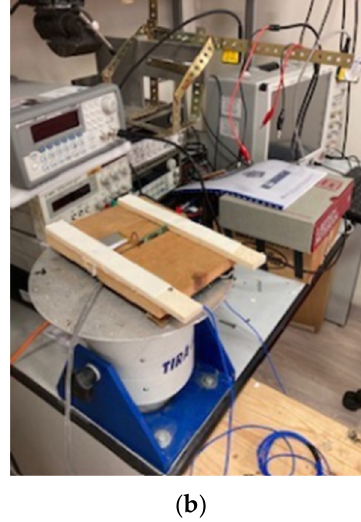
Figure 5. Experimental setup used in laboratory to characterize the IoT-based measurement system: ( a ) sensor inside climate chamber for relative humidity and temperature, ( b ) sensor on copy structure on the shaker.